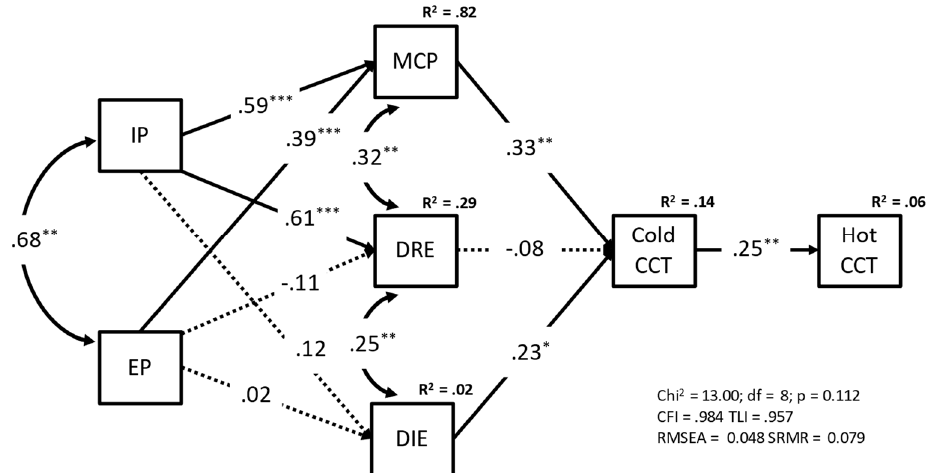
Figure 7. Path model in which maladaptive psychological functioning and difficulties in emotion regulation predicted deliberative and affective risky decisions in teenagers. Note: Standardized es- timates are in the picture. Rectangles represent observed variables. Unidirectional straight arrows represent the regression paths. Bidirectional curved arrows represent covariance. Dotted lines indicate nonsignificant model parameters paths. Legend: IP = Internalizing Problems; EP = Externalizing Prob- lems; MCP = Mixed Cognitive Problems; DRE = Difficulties in Regulating Emotions; DIE = Difficulties in Identifying Emotions. ** p < 0.01; p = p -value; df = degrees of freedom; Chi 2 = Model’s chi square; TLI = Tucker-Lewis fit index; CFI = Comparative Fit Index; RMSEA = Root Mean Square Error of Approximation; SRMR = Squared Root Mean Square Residual; R 2 = R